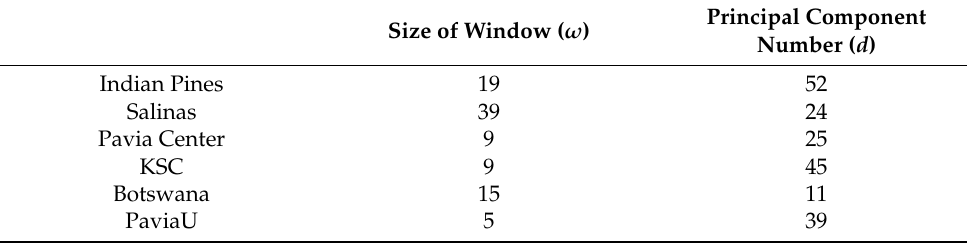
Table 5. The values of the parameters in our method for different datasets with 10 training